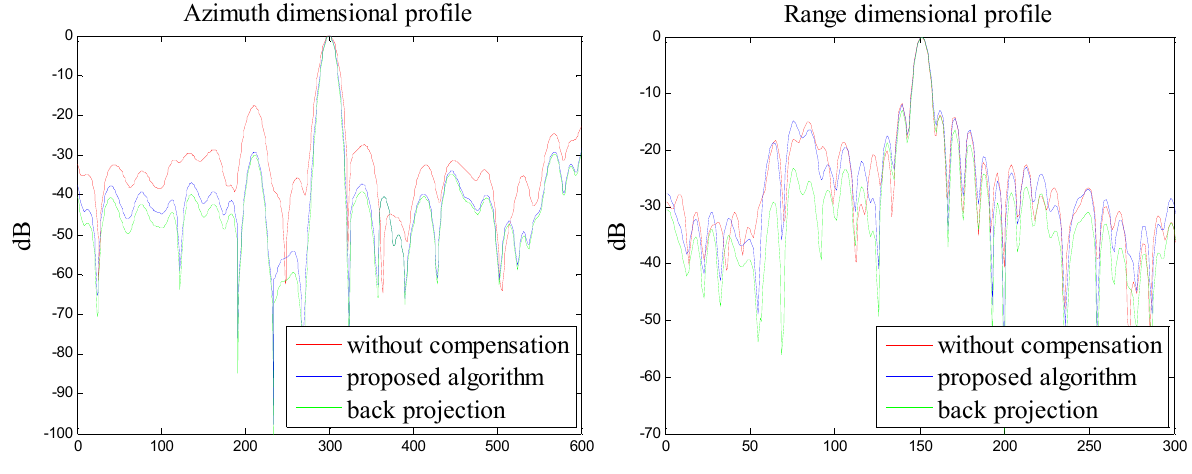
Figure 11. The profile response of the trihedral angle reflector labeled